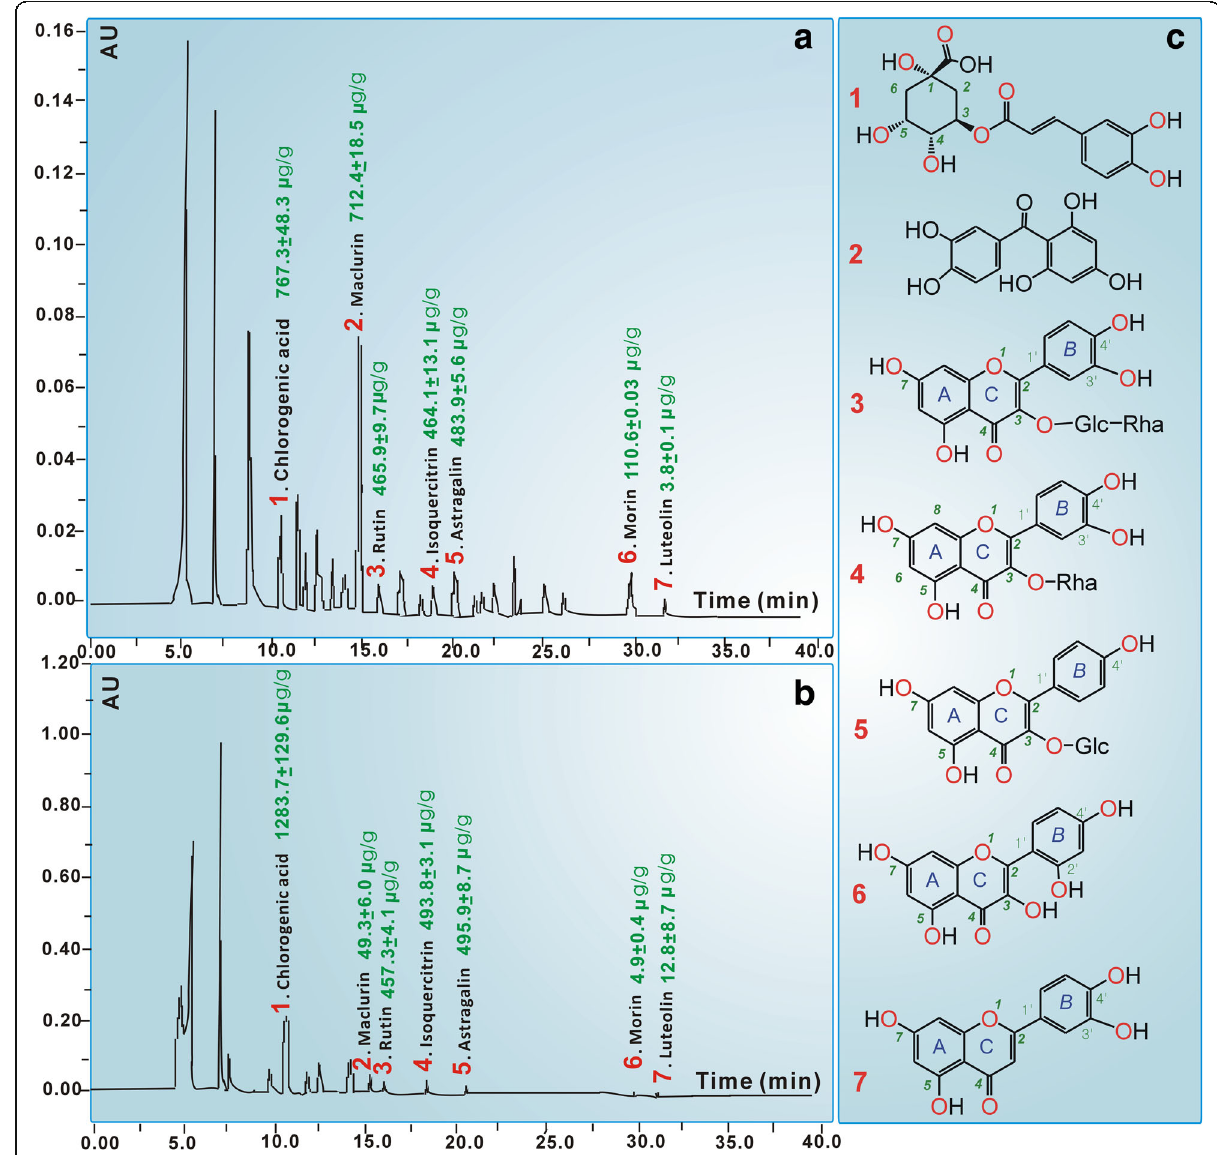
Fig. 3 HPLC profiles and chemical contents of LAMA ( a ) and LAMR ( b ), and structures of relevant phytophenols ( c